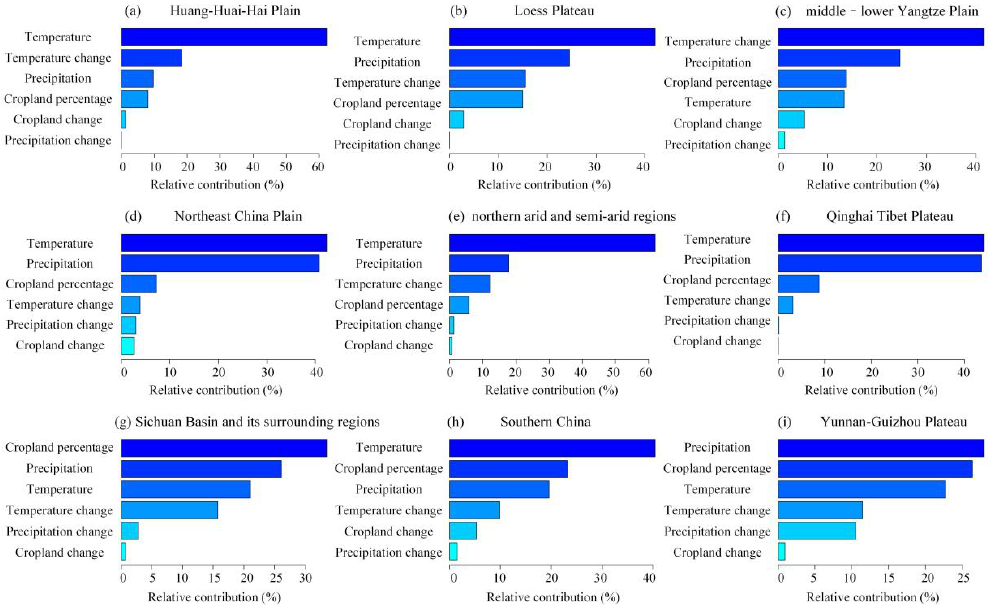
Figure 8. Relative contributions of cropland and climate data on GLASS LAI trends from 1982 to 2015 in the (a) Huang-Huai-Hai Plain, (b) Loess Plateau, (c) middle–lower Yangtze Plain, (d) Northeast China Plain, (e) northern arid and semi-arid regions, (f) Qinghai Tibet Plateau, (g) Sichuan Basin and its surrounding regions, (h) Southern China, and (i) Yunnan-Guizhou Plateau agricultural zones.